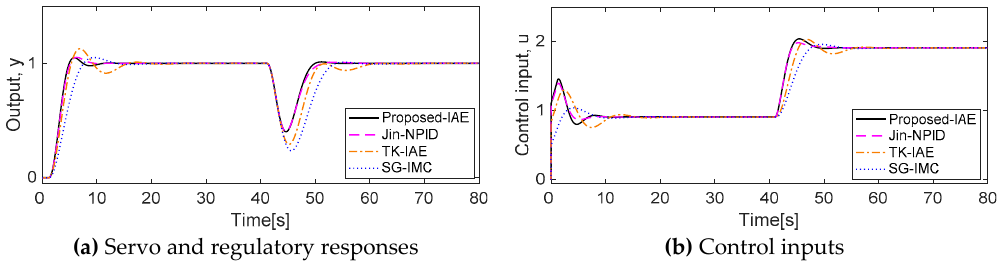
Figure 10. Servo and regulatory responses for process 2 under 10% mismatch. Table 6. Quantitative comparison of performances for process 2 under 10% mismatch.